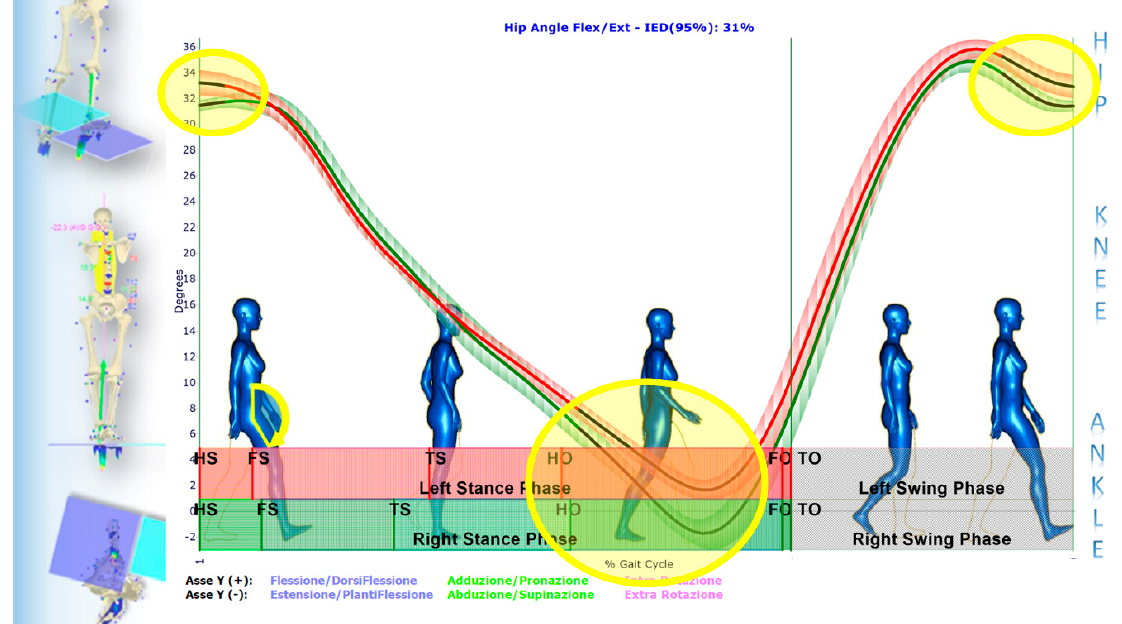
Figure 9. Mean gait cycle: lower limbs hip flexion–extension joint angles. The yellow ellipses highlight the sub-regions in which the left (red colours) vs. right (green colours) variable’s temporal courses point-by-point t-Test is significant ( p < 0.05) (black-coloured lines). The lower bars, left (red colours) vs. right (green colours), report the stance phases’ sub-events. They are automatically identified by elaborating baropodometric data and segmenting the foot pressure maps into foot sub-regions (HS = Heel Strike, FS = Forefoot Strike, TS = Toe Strike, HO = Heel Off, FO = Forefoot Off, TO = Toe Off). IED values at the top of each panel indicate the left vs. right percentage asymmetry.